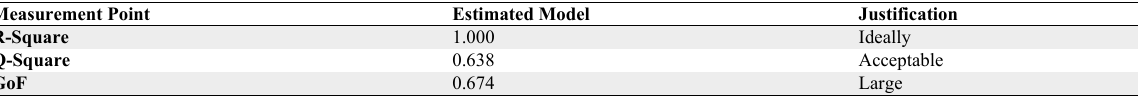
Measurement Result Model Fit